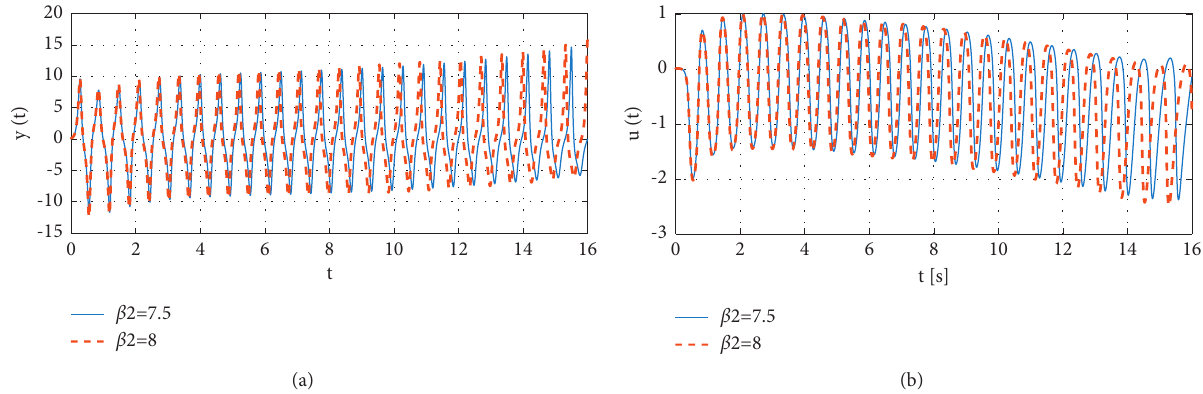
Figure 8: Time series solutions of the state variables y ( t ) and u ( t ) of system (25) for different parameter values of β